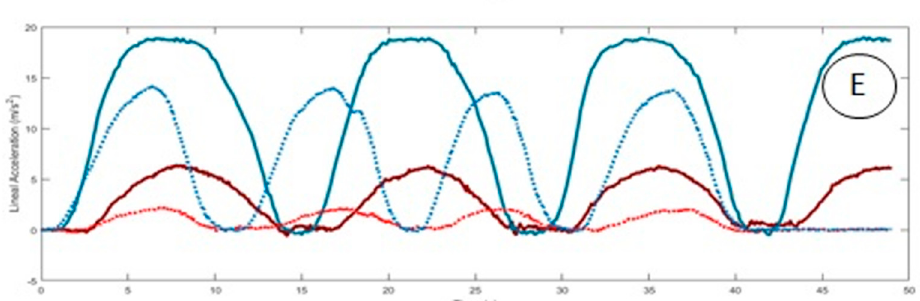
Figure 1. ( A ) Inertial sensors placement in the scapula (1), humerus (2), sternum (3) and forearm (4). ( B ) Mark placed on the floor to indicate frontal, lateral and scapular plane, as an intermediate line. ( C ) Example of SHR (°) during scaption. Blue represent humerus AB-AD. Red represents scapular PR-RE in asymptomatic control (continuous line) and pathological subject (discontinuous line). ( D ) Example of SHR (°/s) during scaption. Blue represent humerus AB-AD. Red represents scapular PR-RE in asymptomatic control (continuous line) and pathological subject (discontinuous line). ( E ) Example of SHR (m/s2) during scaption. Blue represent humerus AB-AD. Red represents scapular PR-RE in asymptomatic control (continuous line) and pathological subject (discontinuous line). SHR = Scapulo-humeral rhythm.